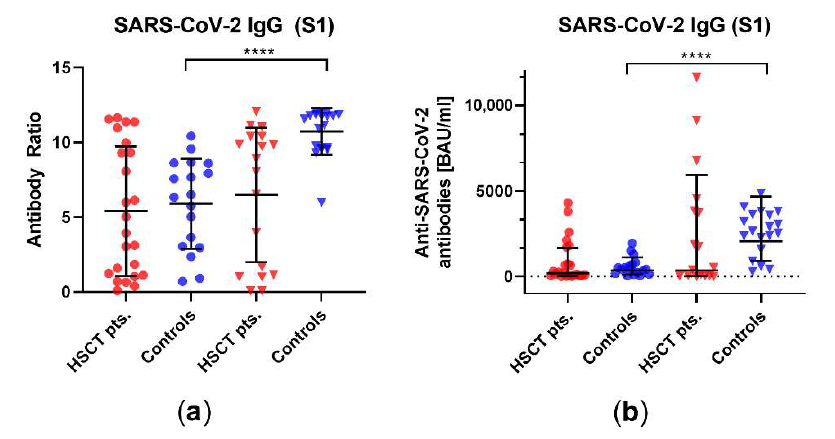
Figure 5. SARS-CoV-2-specific IgG antibody responses in HSCT patients and healthy controls before and after the third vaccination. SARS-CoV-2-specific IgG antibody responses are shown ( a ) as antibody ratios, which determines a quotient of antibodies in the patient samples and in a control sample, and ( b ) as SARS-CoV-2-specific IgG antibody concentrations in units of BAU/mL. Circles indicate data before the third vaccination (red—HSCT, blue—healthy controls), while triangles indicate data after the third vaccination. Responses were compared by two-tailed Mann–Whitney test (**** p < 0.0001). The dotted line represents the zero line. For the antibody ratio, horizontal lines indicate mean values, while error bars indicate the standard deviation. For the antibody concentration, the geometric mean and geometric standard deviation factor are